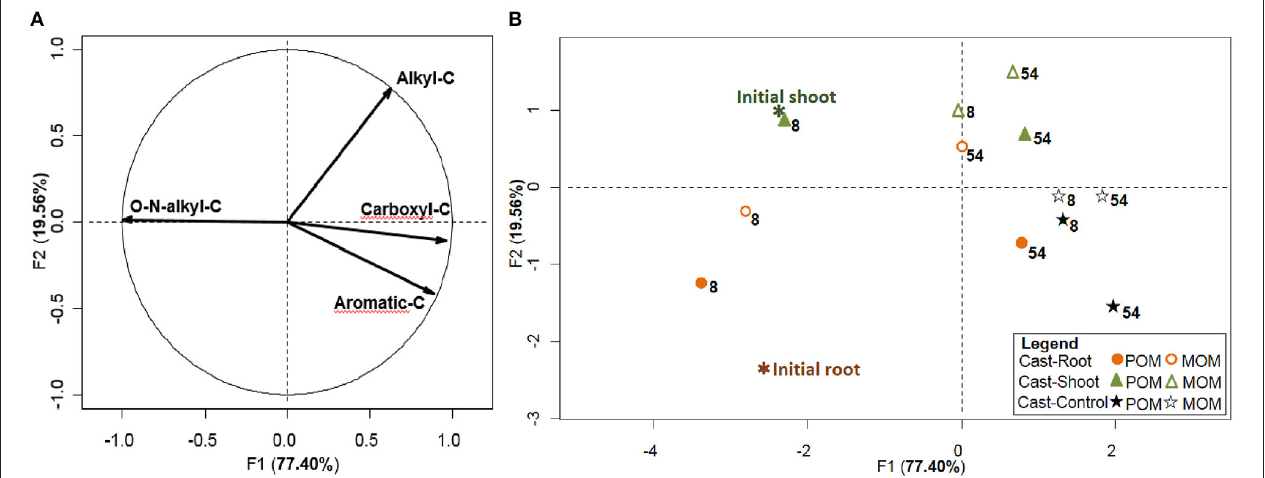
FIGURE 2 | Chemical characterization of earthworm casts. PCA carried out with the 4 variables of the 6 cast samples, fractionated into POM and MOM. The variables correspond to the 4 chemical shift regions integrated from 13 C CPMAS NMR. (A) distribution of variables on the correlation circle and (B) distribution of the cast samples, with root and shoot litter as illustrative samples. Weeks after the beginning of the experiment are indicated using numbers next to